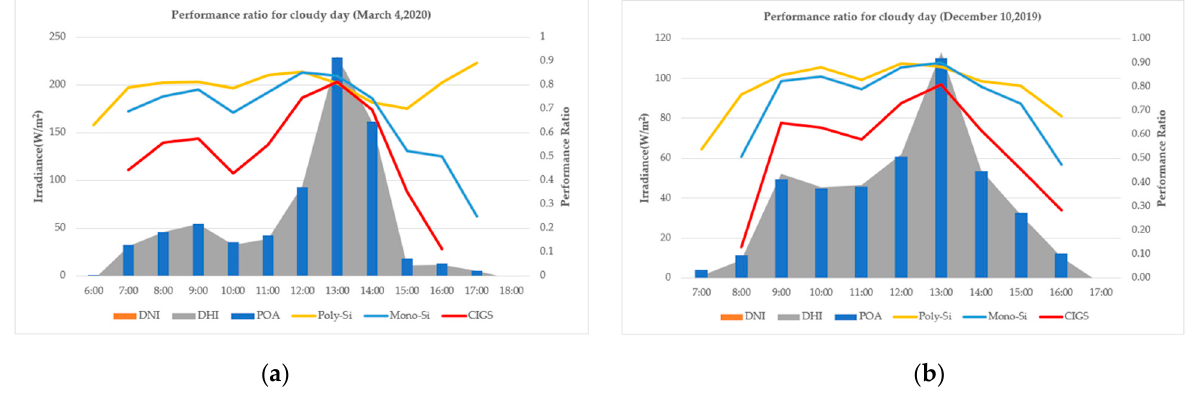
Figure 7. Performance ratio and irradiance on clear days: ( a ) 2 December 2019 ( b ) 6 March 2020.